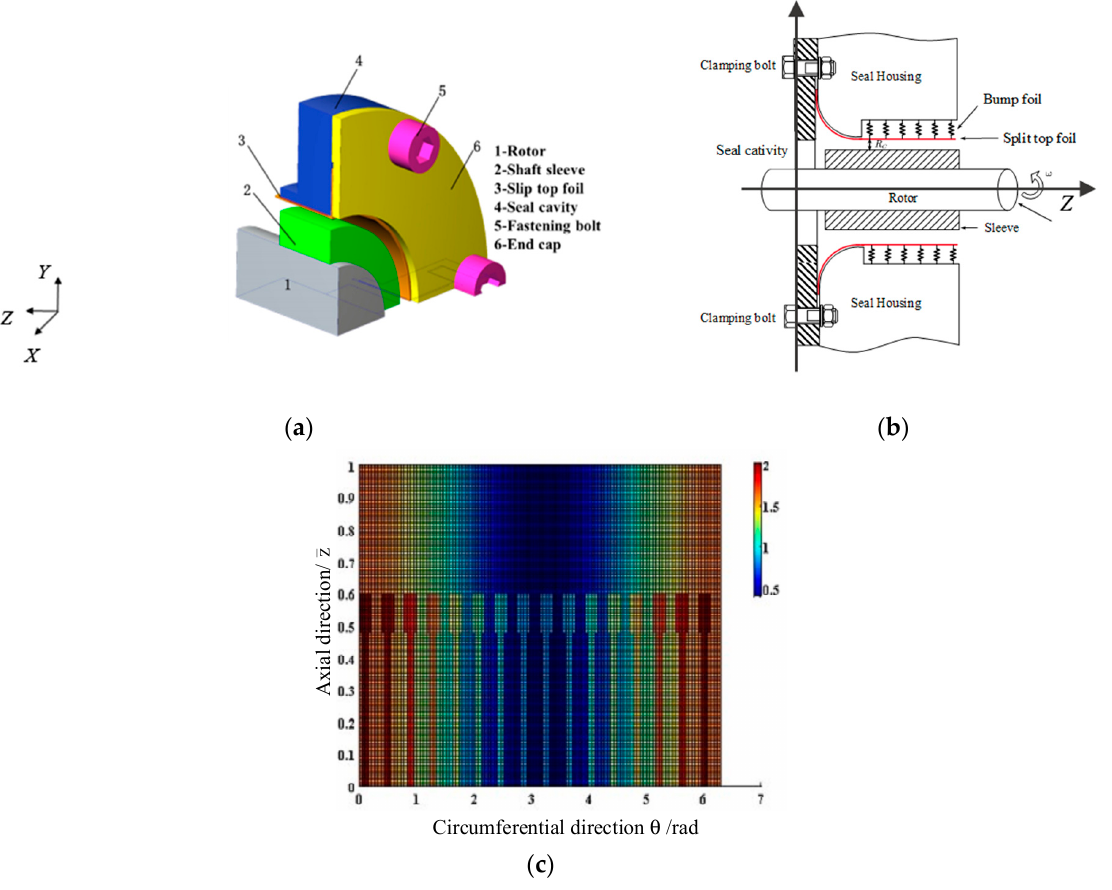
Figure 1. The analysis model of compliant foil gas seal. ( a ) The three-dimensional model of compliant foil gas seal; ( b ) The schematic of compliant foil gas seal; ( c ) The T groove layout of compliant foil Table 1. The parameters of compliant foil gas seal.